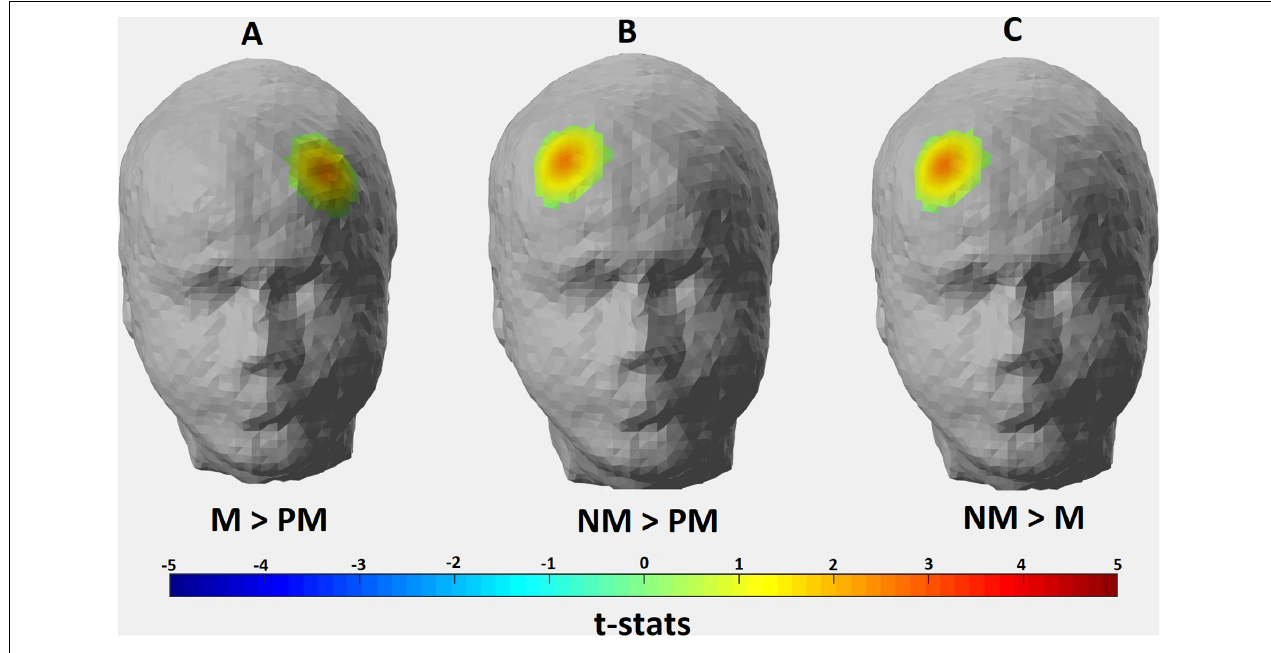
FIGURE 5 | Hemodynamic activity strength parameter map depicting the contrasts for (A) Match > Perfect Match; (B) Non Match > Perfect Match; and (C) Non Match > Match conditions. Channels depicting statistically significant contrast ( p > 0.05) were mapped onto a standard head model with their thresholded t-statistics score for each condition